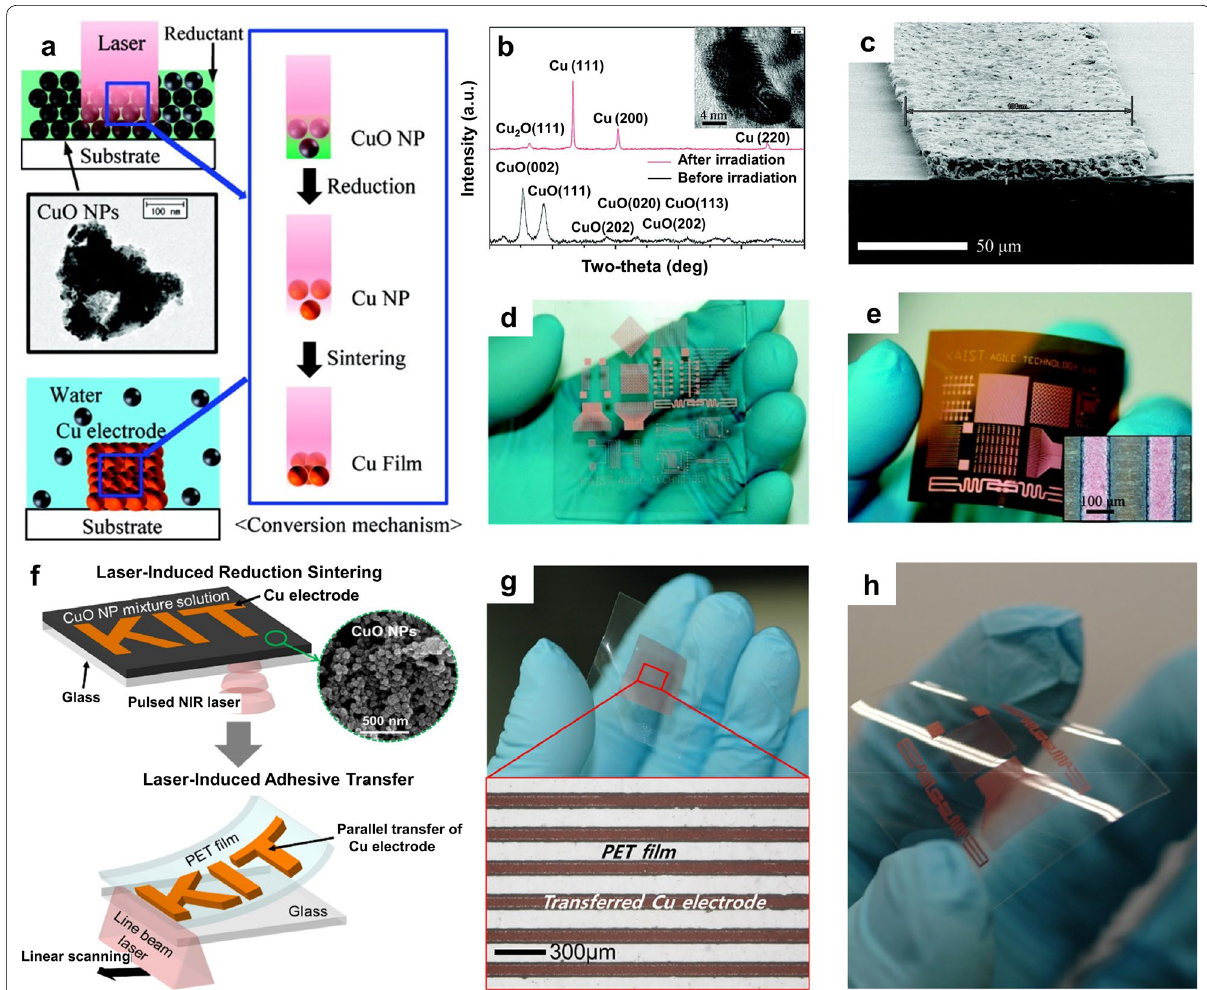
Fig. 5 a Schematic of the proposed process for the conversion of CuO NPs into a Cu film via photochemical reduction and photothermal agglomeration. b XRD analysis results obtained before and after laser irradiation; (inset) TEM image of a Cu film processed using a pulsed laser. c Cross-sectional SEM image of the Cu electrode. d, e Photograph of Cu electrode patterns on a glass substrate and a PI substrate, respectively ( a – e reproduced with permission from Ref. [77]. Copyright American Chemical Society 2011). f Schematic of the fabrication procedures for laser-induced reductive sintering and laser-induced adhesive transfer. g Photograph and microscope image of Cu NP electrodes transferred to a PET receiver film at a laser power of 2 W and a laser scanning speed of 2000 mm min − 1 . h Photograph of arbitrary Cu electrode patterns transferred to the PET film ( f – h reproduced with permission from Ref. [81]. Copyright Elsevier,